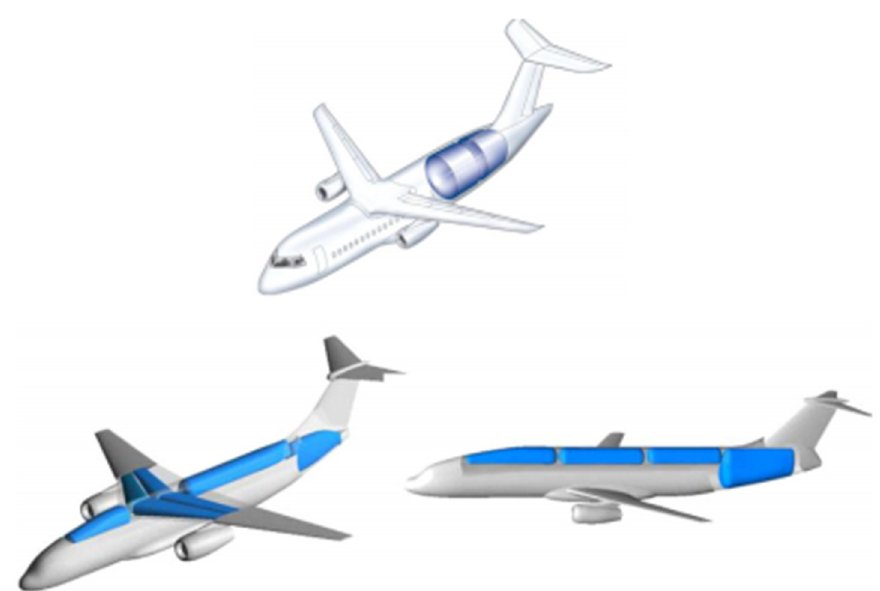
Figure 2. Liquefied hydrogen aircraft with different tank configurations [10].